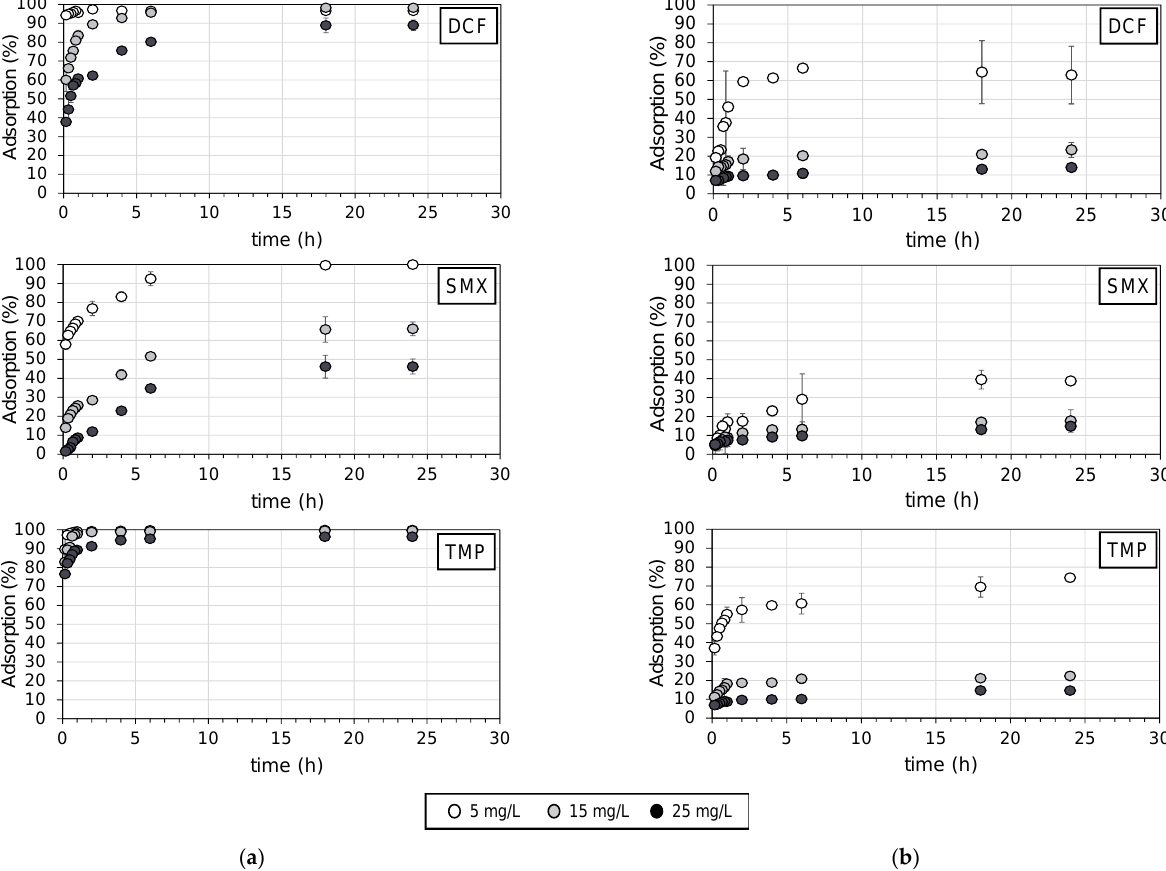
Figure 2. Kinetics of adsorption of DCF, SMX and TMP at three different concentrations in Milli-Q water with ( a ) 1 g/L of PAC and ( b ) 0.1 g/L of PAC at different contact times (10 min–24 h). Error bars indicate the standard